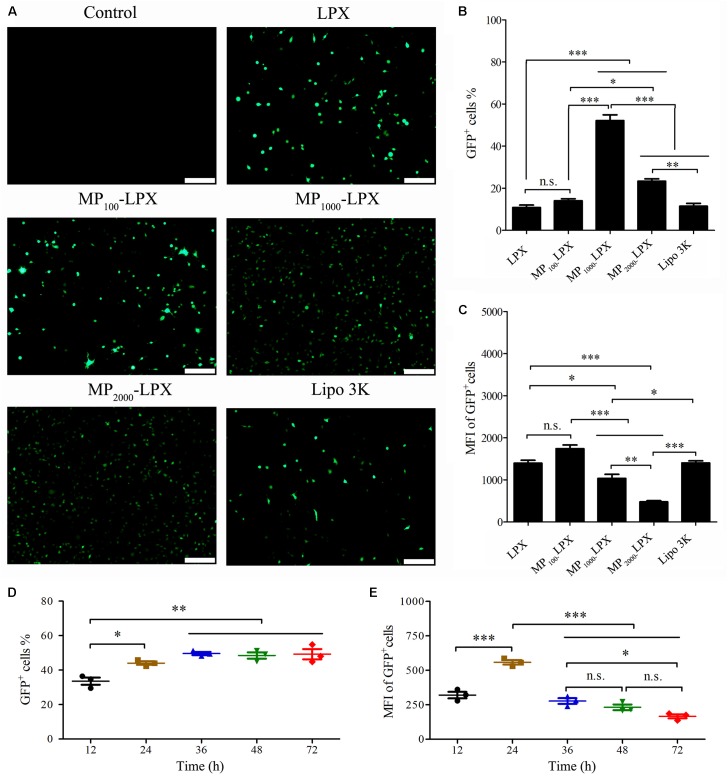
Transfection of MPn-LPX with different PEGs length on DC2.4 cells at N/P 5. (A) GFP expression by DC2.4 cells observed by a fluorescence microscope. Transfection efficiency (%GFP+ cells) (B) and MFI of GFP+ cells (C) were quantified. Kinetics of MP1000-LPX NP 5 transfection efficiency (D) and MFI of GFP positive cells (E) on DC2.4 cells from 12 h to 72 h. Scale bars, 200 μm. ∗p < 0.05; ∗∗p < 0.01; ∗∗∗p < 0.001.